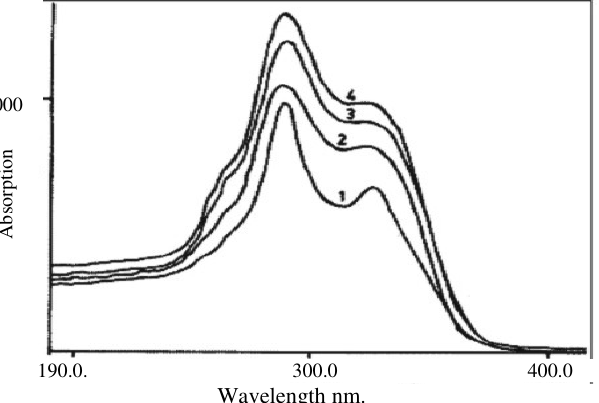
Figue 2 . Electronic spectra of terpolymer resins (1) 2, 4-DHBOF-I, (2) 2, 4-DHBOF-II, (3) 2, 4-DHBOF-III, (4) 2,